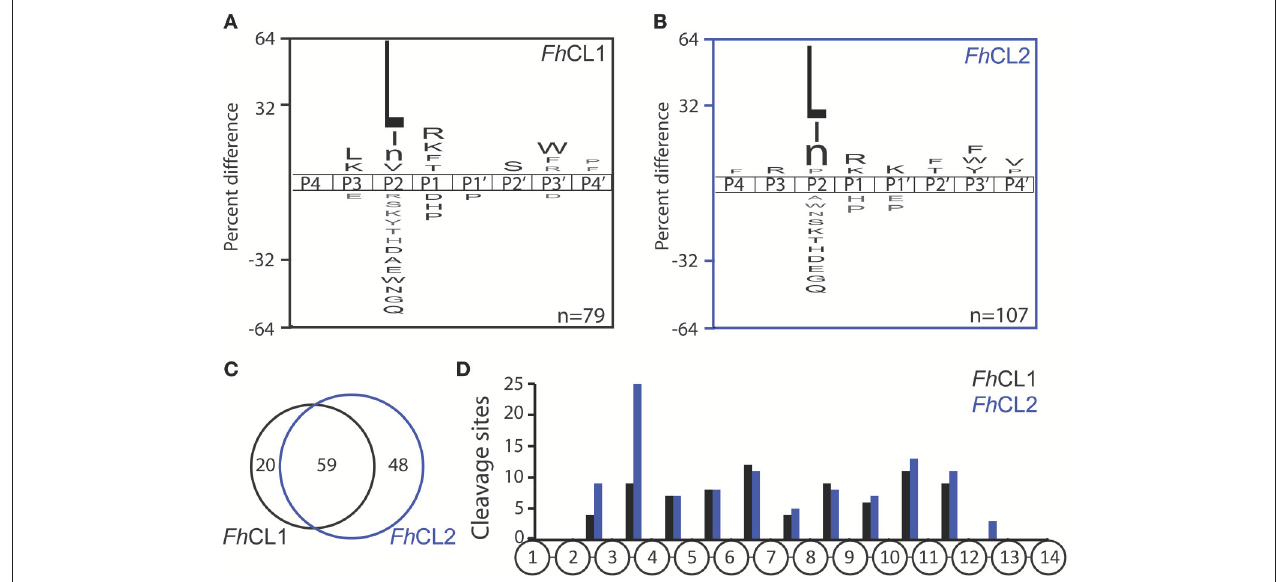
FIGURE 2 | Differential cleavage specificities of Fh CL1 and Fh CL2 using MSP-MS. A. iceLogo plot illustrating the frequency of amino acids found in the P4-P4 ′ position of (A) Fh CL1 and (B) Fh CL2, following incubation with the 228-member peptide library for 4h. Amino acids that are significantly enriched (top) or de-enriched (bottom) ( p ≤ 0.05) are colored black. Lowercase “n” in the amino acid list corresponds to norleucine. The number of cleavage sites used to build the iceLogo plot is indicated in the right lower corner of the plot. (C) Venn diagram showing the number of shared and unique cleavage sites for Fh CL1 (black) and Fh CL2 (blue). (D) Distribution of the cleavage sites observed within the 14-mer peptides.